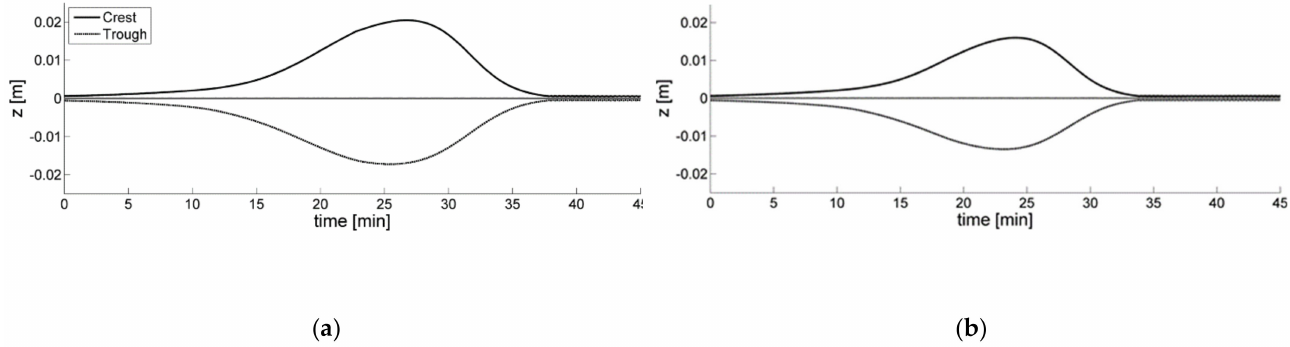
Figure 22. Dune crest and trough position for the first 45 min of scenario A4 of Shimizu et al. (2009) [14]) with ( a ) α max = 300 and ( b ) α max =